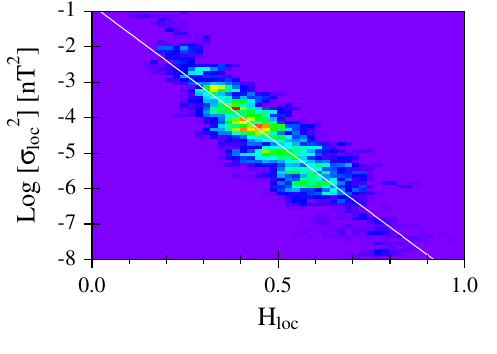
Fig. 14. The occurrence plot of the dependence of the local Hurst exponent H loc , computed by DMA technique, on the corresponding local variance σ 2 loc for synthetic mBm signal. The solid white line is a linear fit of the corresponding scatter plot, denoting a clear negative correlation ( r ∼ − 0 . 88 ) between log 10 [ σ 2 loc ] and H loc . The used color palette is the same of Figure 13. p(H) being the distribution function of the local Hurst expo- nents. Fig. 15. The H loc -conditioned probability distribution functions P ( y | H loc ) of the standard-deviation-normalized small-scale (1 min) increments for different values of H loc in the range [0 . 5 , 0 . 9] . Upper/lower panel refers to year 2001/2008, respectively.